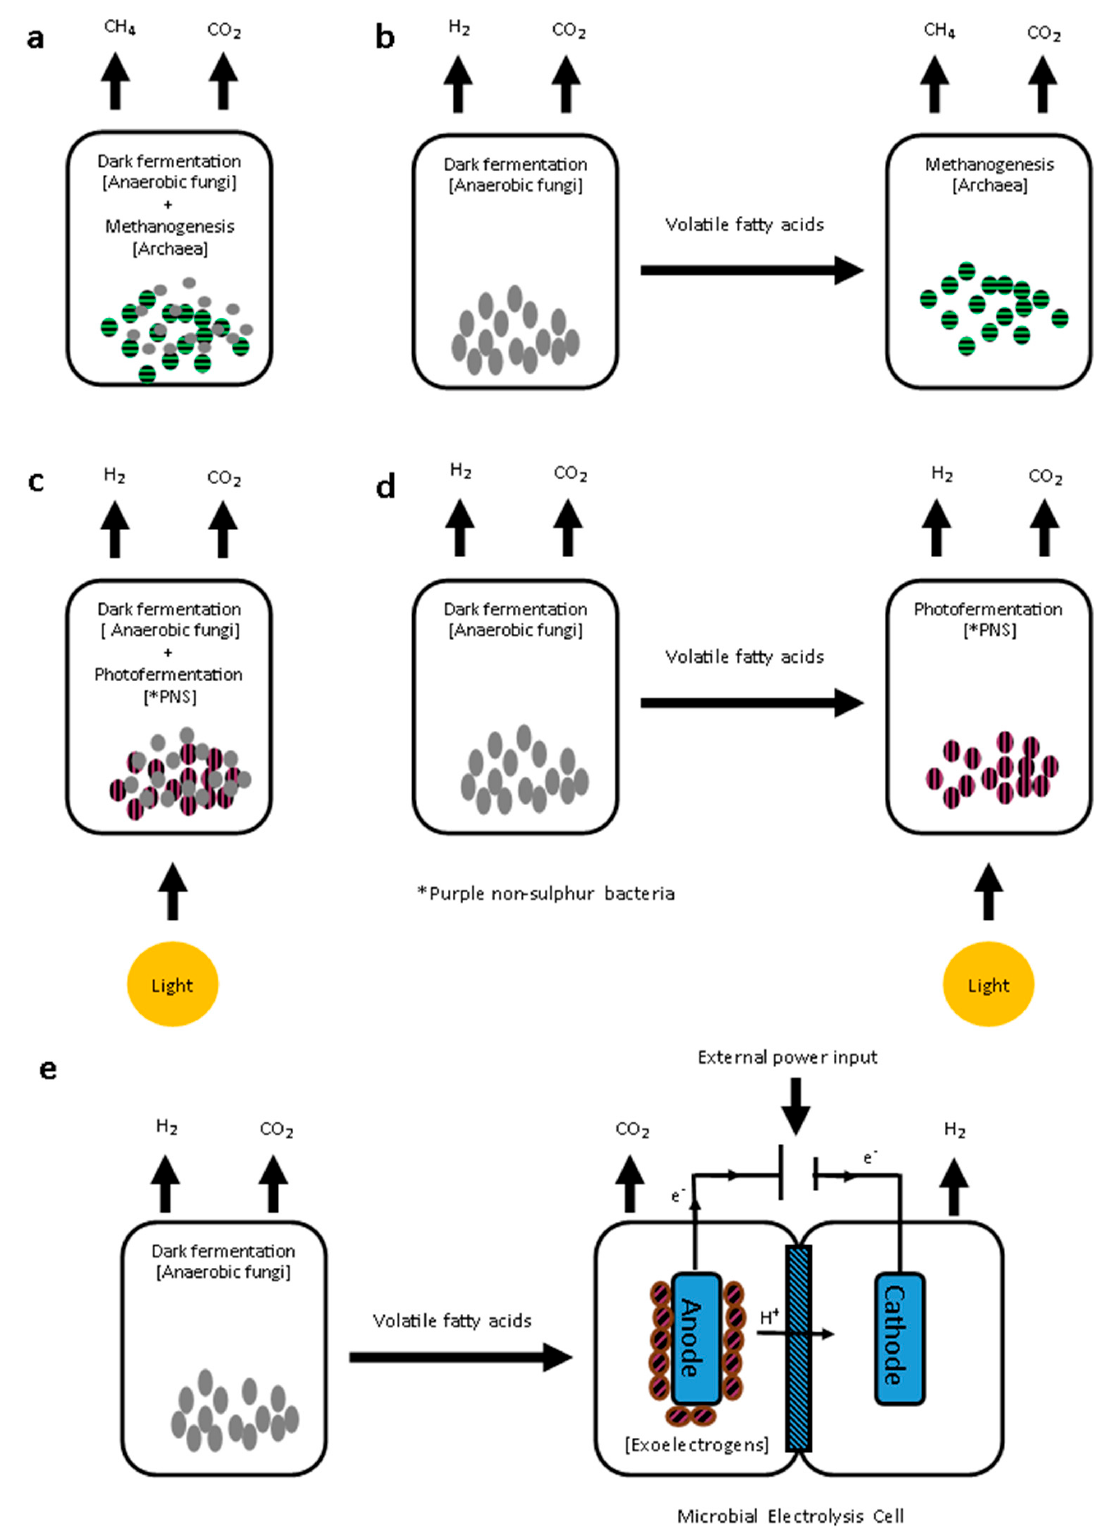
Figure 4. A schematic representation of the incorporation of anaerobic fungi into ( a ) single-stage biomethane production; ( b ) two-stage dark fermentation and methanogenesis; ( c ) single-stage dark fermentation and photofermentation; ( d ) two-stage dark fermentation and photofermentation; and ( e ) two-stage dark fermentation and microbial electrolysis.